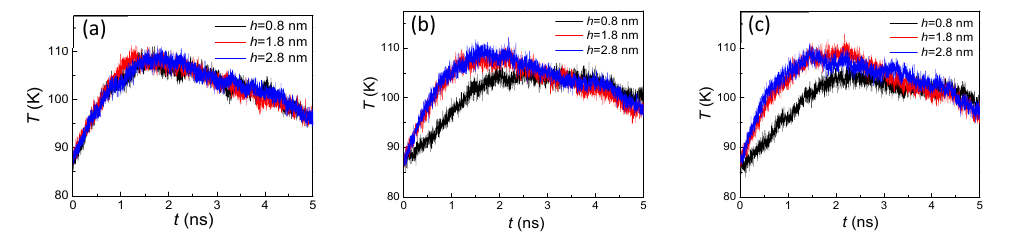
Figure 9. The temperature of argon atoms with three groove heights and widths of ( a ) 1.8, ( b ) 2.4, and ( c ) 3.2 nm on hydrophobic surfaces.